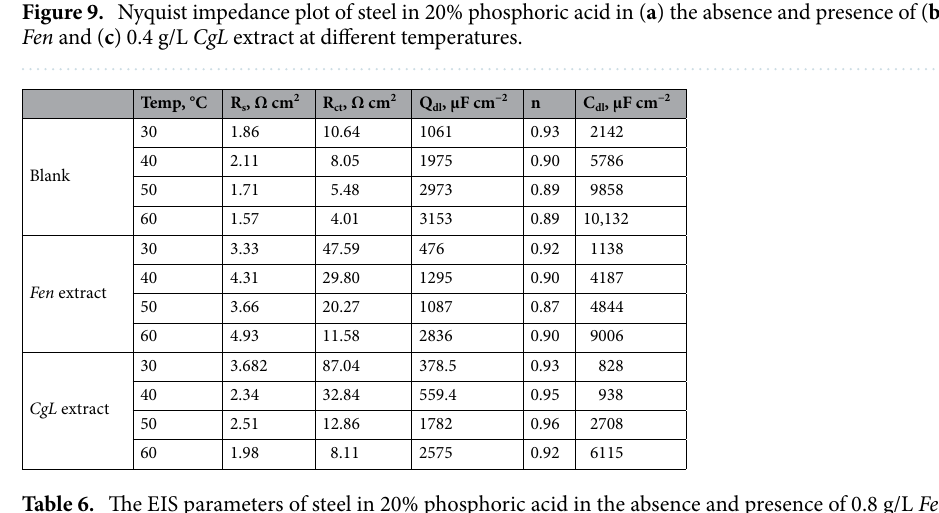
Table 6. The EIS parameters of steel in 20% phosphoric acid in the absence and presence of 0.8 g/L Fen and 0.4 g/L CgL extract at different